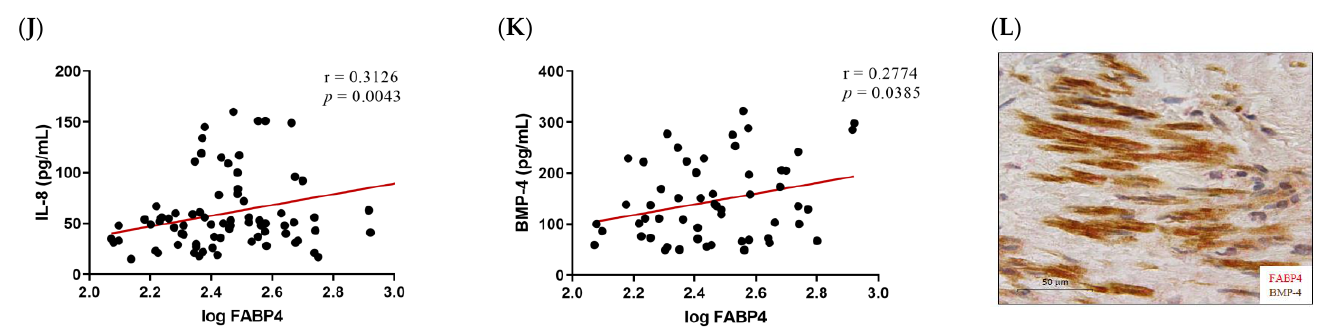
Figure 3. The associations of FABP4 with inflammatory, apoptotic, and calcification markers in AVs from male AS patients. Correlations between the protein levels of FABP4 and the inflammatory molecules ( A ) IL-6 and ( B ) Rantes. ( C ) The representative microphotograph of FABP4 (red)/Rantes (brown) double immunostaining in the AV sections of male AS. Correlations between the protein levels of FABP4 and the apoptotic markers ( D ) Bax, ( E ) caspase-3, and ( G ) Bcl-2. Representative microphotographs of FABP4 (red)/caspase-3(brown) ( F ) double immunostainings in AV sections of male AS. Correlations between the protein levels of FABP4 and the calcification markers ( H ) BMP-2, ( J ) IL-8, and ( K ) BMP-4. The representative microphotographs of ( I ) FABP4/BMP-2 and ( L ) FABP4/BMP-4 double immunostainings in the AV sections of male AS. AV: aortic valve; AS: aortic stenosis; FABP4: fatty acid-binding protein 4; IL: interleukin; Bcl-2: B-cell lymphoma 2; BMP: bone morphogenetic protein. N = 33 – 116.